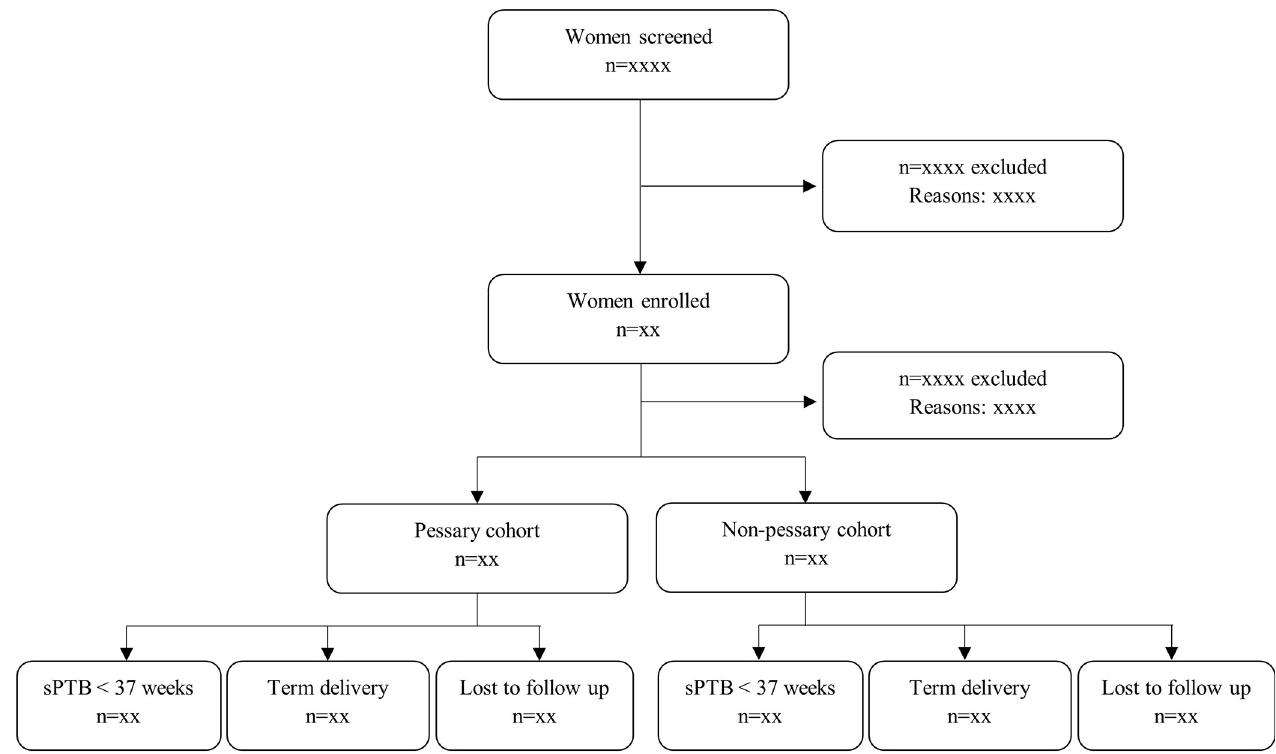
Fig 4. Flowchart summarizing the distribution of subjects in the study. sPTB = spontaneous preterm birth.